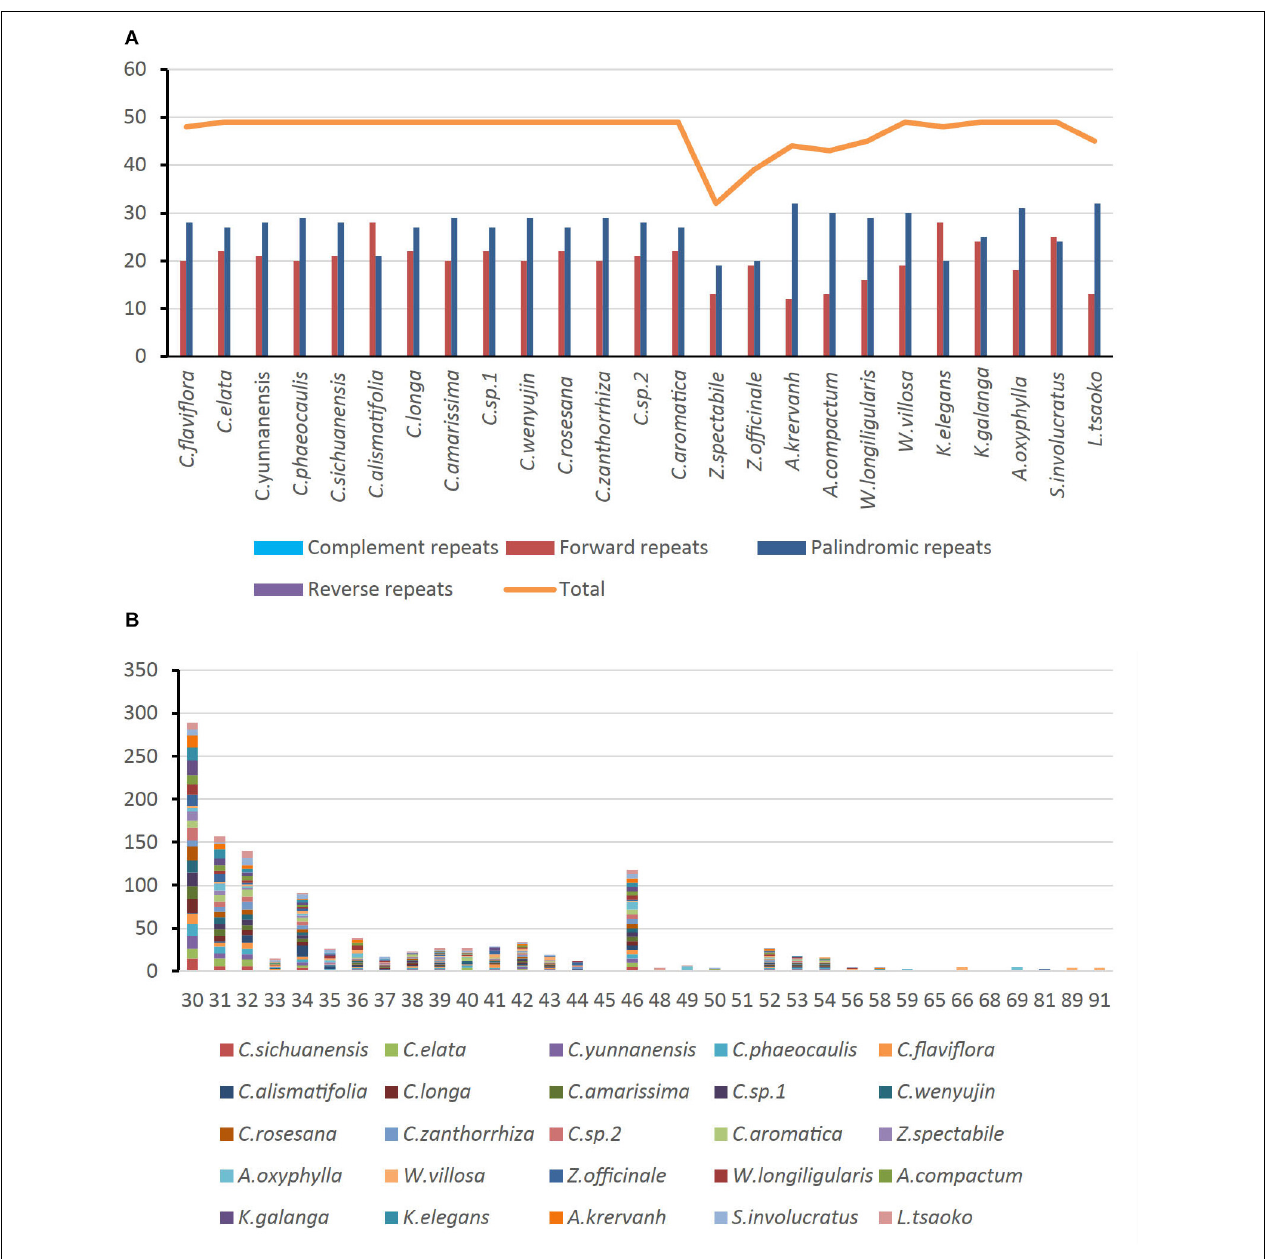
FIGURE 4 | Number of long repetitive repeats on the complete chloroplast genome sequence of 25 Zingiberaceae species; (A) frequency of repeat type; (B) frequency of the repeats.